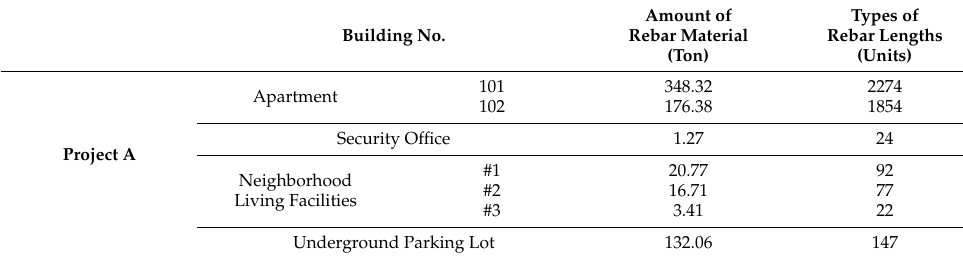
Table 4. The amounts of rebar material and the number of LPRS for wall